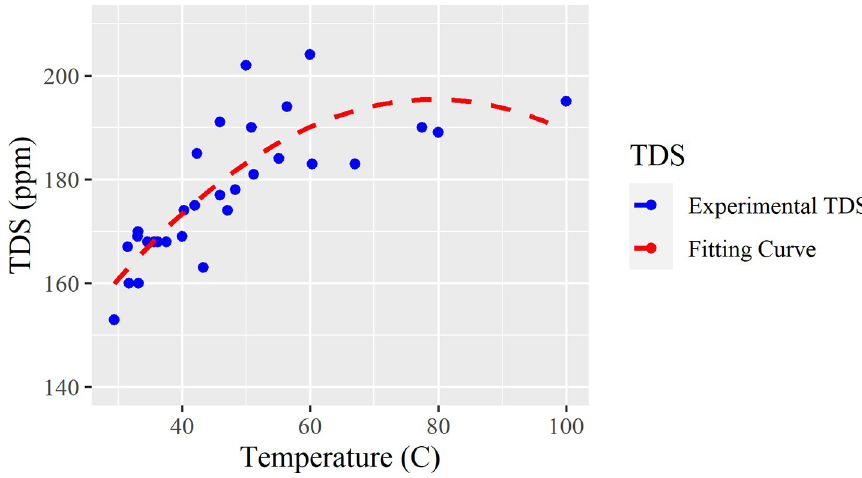
Fig 4. Scatterplot and a fitting curve of TDS under different